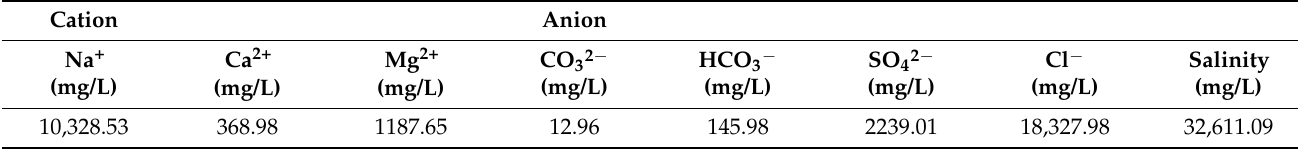
Table 1. The composition of simulated Bohai seawater, supplied by CNOOC EnerTech-Drilling and Production